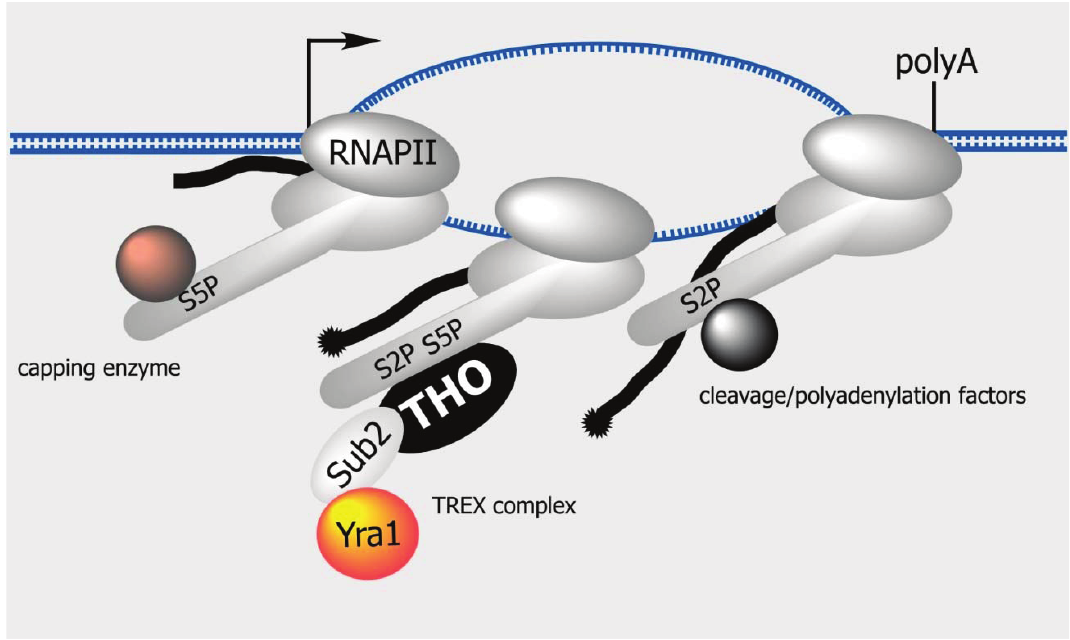
Figure 3. Co-transcriptional loading of the TREX complex. The carboxy-terminal domain (CTD) of RNAPII is subjected to transcription-cycle-specific modifications. Ser5 of CTD is phosphorylated when RNAPII is near the promoter. The capping enzyme specifically binds to the Ser5-phosphorylated CTD, allowing capping to occur early during transcription initiation. Ser2 phosphorylation gradually increases during transcription elongation and becomes dephosphorylated near the transcription termination site. Factors involved in cleavage/polyadenylation specifically bind to the Ser2-phosphorylated CTD. Recent data indicate that the THO subcomplex of the yeast TREX complex specifically and directly interacts with the Ser2/Ser5-diphosphorylated CTD